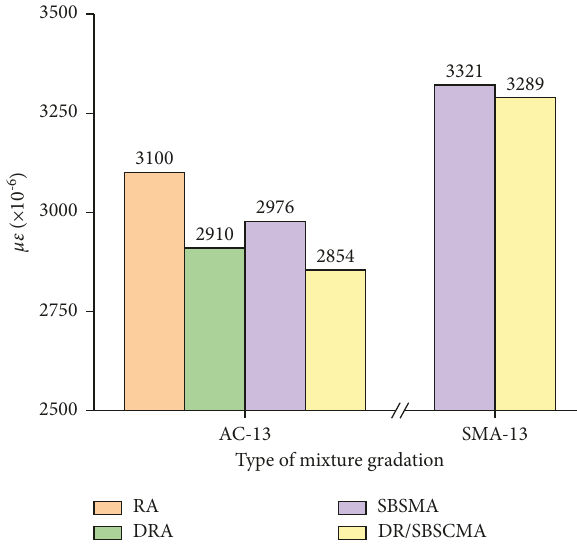
Figure 12: Creep rate test results.